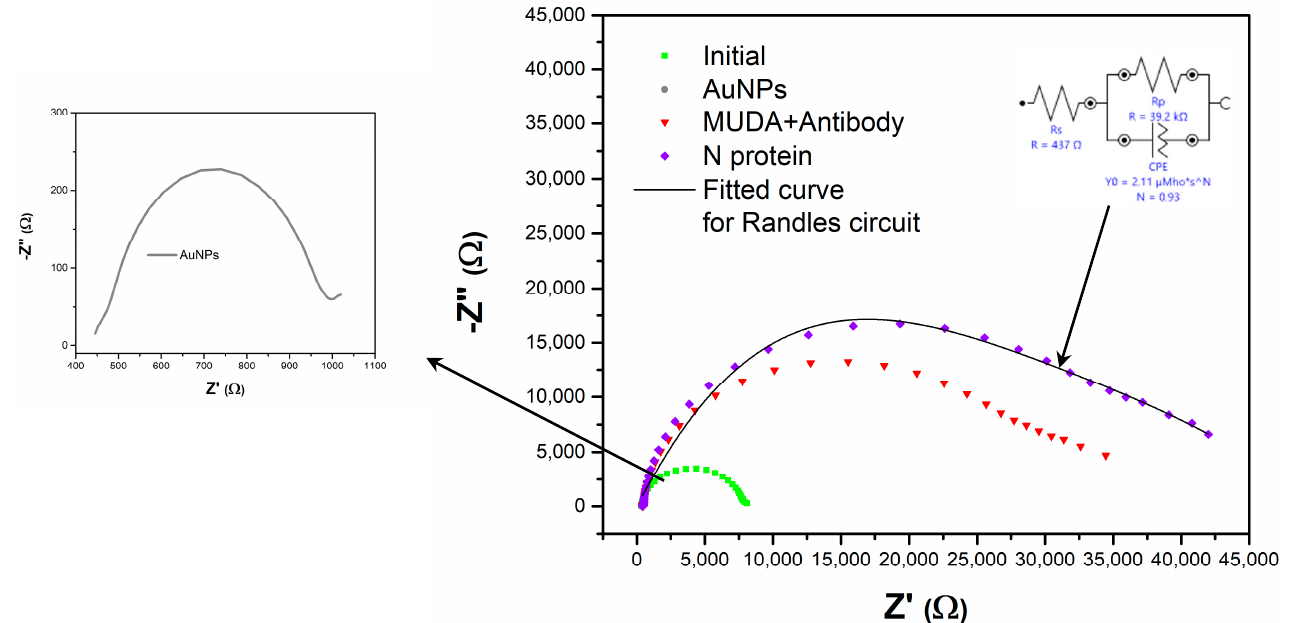
Figure 7. Nyquist diagram for the S7/02.08 sensor (WE area = 12.6 mm 2 ) with measurements after AuNP decoration, MUDA functionalization + antibody immobilization (one step), and N-protein binding.